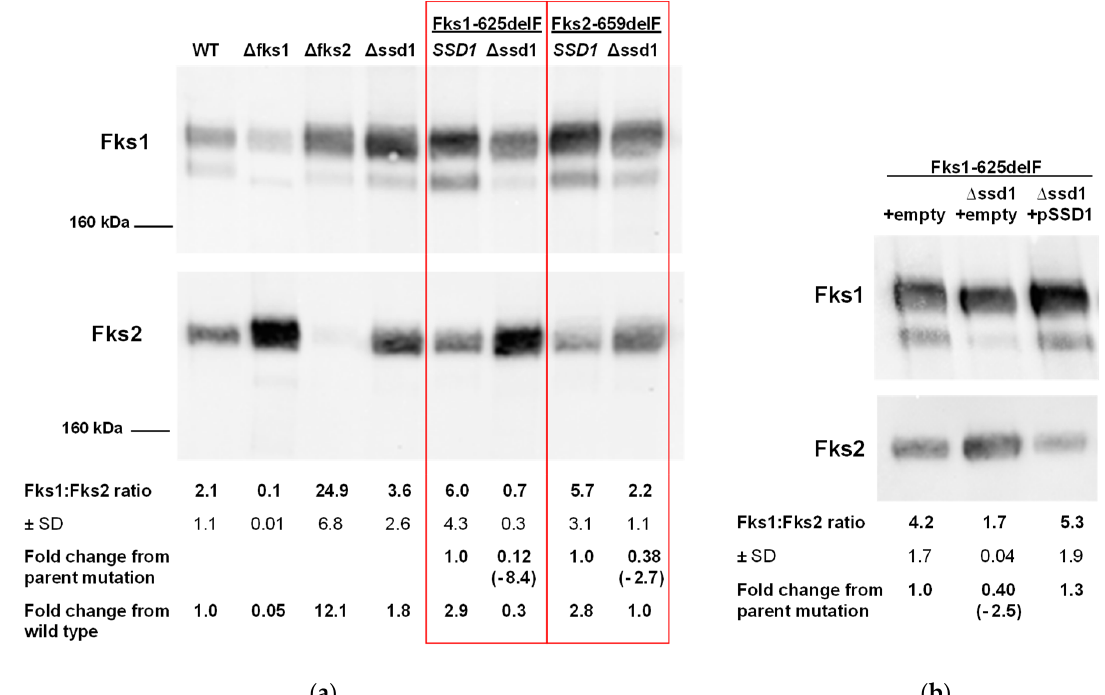
Figure 3. SSD1 deletion leads to decreases in Fks1:Fks2 protein ratios in FKS1 mutants. ( a ) SSD1 deletion in the FKS mutant backgrounds (squared in red) leads to a decrease in Fks1:Fks2 protein ratio. ( b ) Plasmid expression of SSD1 complements the decrease in Fks1:Fks2 protein ratio observed in the fks1 ∆ ssd1 mutant. Glucan synthase enzyme was purified from strains and western blotting performed with anti-CgFks1 or anti-CgFks2 antibodies that recognize N-terminal epitopes. ImageJ software was used to determine band intensities (integrated densities) and ratios of Fks1 to Fks2 were calculated. Representative blots from two independent experiments and mean ratios plus/minus SD are shown.